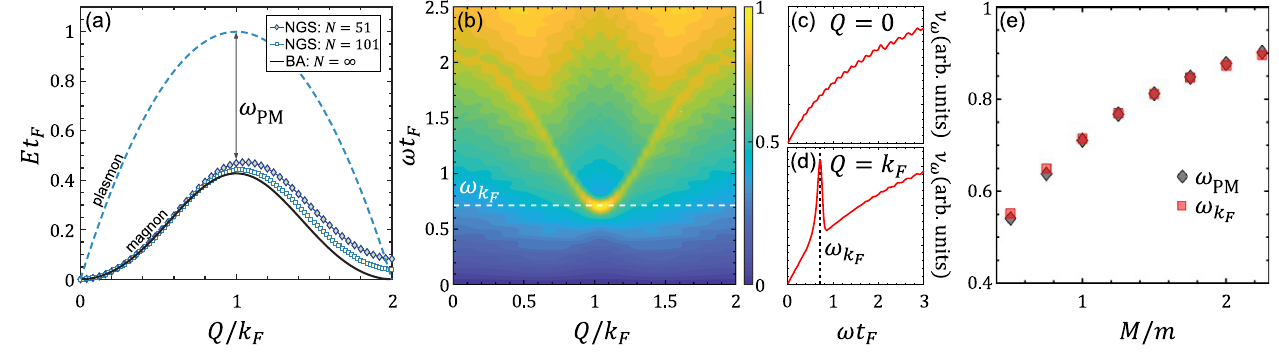
FIG. 1. (a) Polaron energy-momentum relation — the magnon branch — for the case of equal masses M ¼ m and the plasmon branch of the host Fermi sea. Note the plasmon-magnon excitation energy ω at k . Our variational NGS approach remarkably reproduces the F PM exact BA result (solid line), adopted from Refs. [42,47] (here we used Λ ¼ 10 k ). (b) Density of states (DOS) of collective excitations as F 1 =E a function of frequency ω and total momentum Q . Here t is the Fermi time. Note that the spectral signal becomes particularly F ¼ F pronounced at Q ¼ k . (c),(d) Cuts of the DOS at Q ¼ 0 and Q ¼ k , respectively. Dashed line in (d) [shown also in (b)] indicates the F F emergence of a sharp mode. (e) The collective mode ω , as a function of the mass ratio M=m , matches the plasmon-magnon mode ω k F from (a). Parameters used are γ ¼ 5 , N ¼ 51 , and Λ ¼ 5 k F